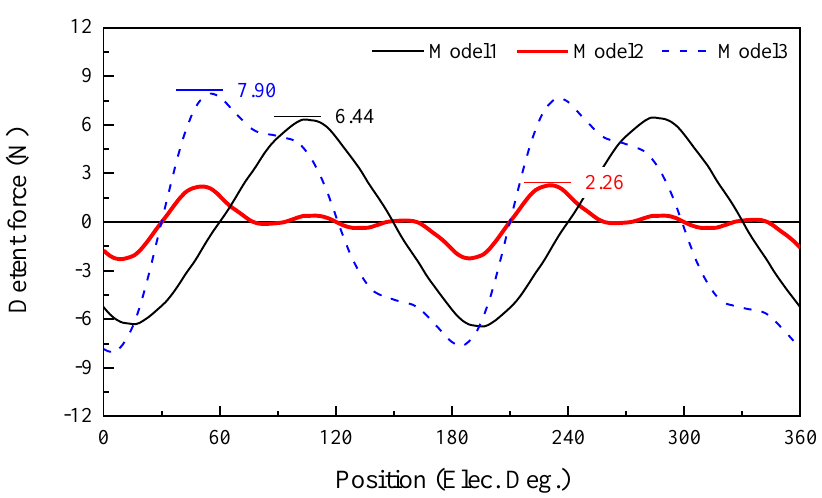
Figure 4. Detent force waveform comparison.